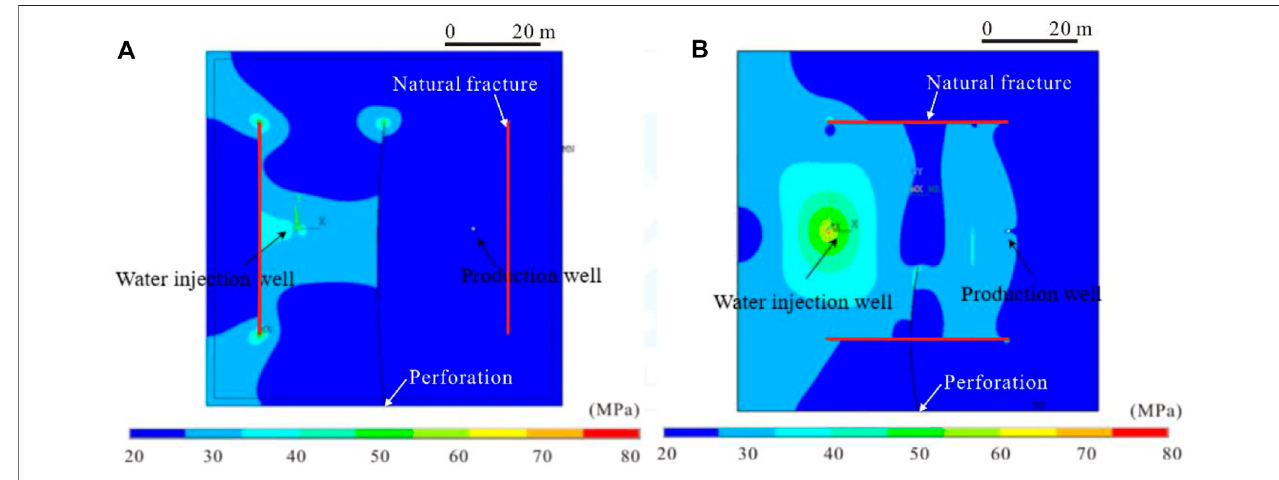
FIGURE 7 | Hydraulic fracturing effect under the condition that the fracturing direction is parallel or perpendicular to the main strike of natural fractures. (A) The fracturing direction is parallel to the main strike of natural fractures; (B) the fracturing direction is perpendicular to the main strike of natural fractures.